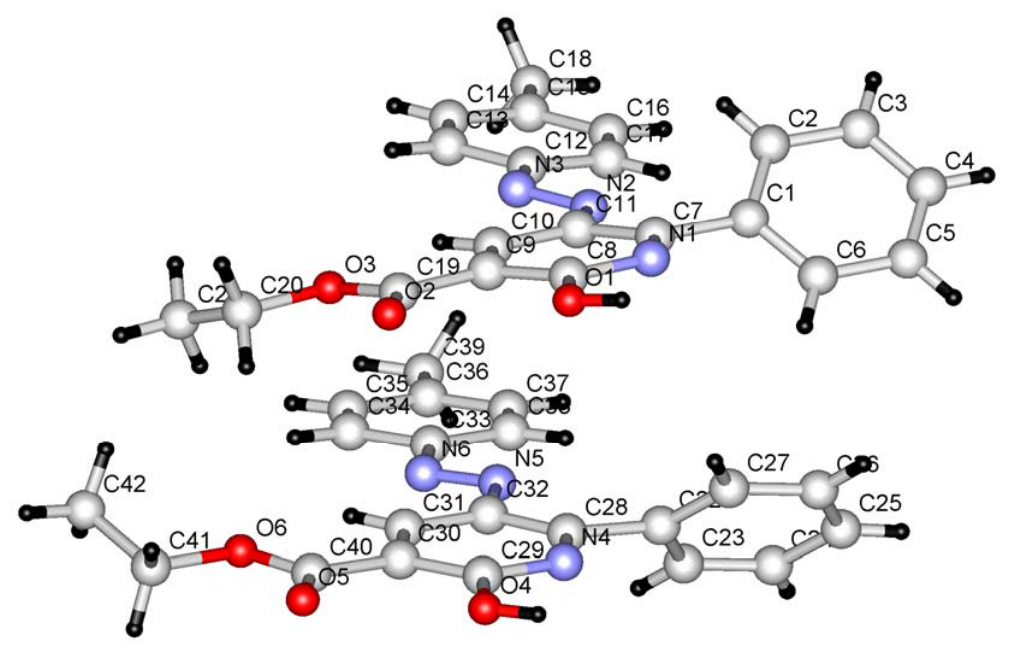
Figure 1. Ball and stick drawing of 6a .